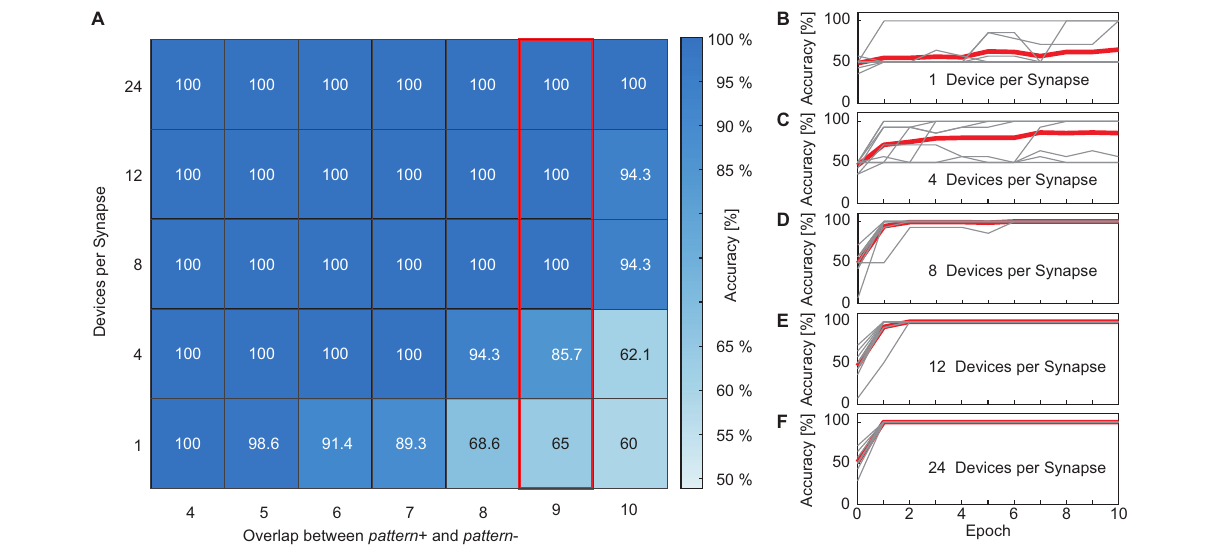
Frontiers in Neuroscience |